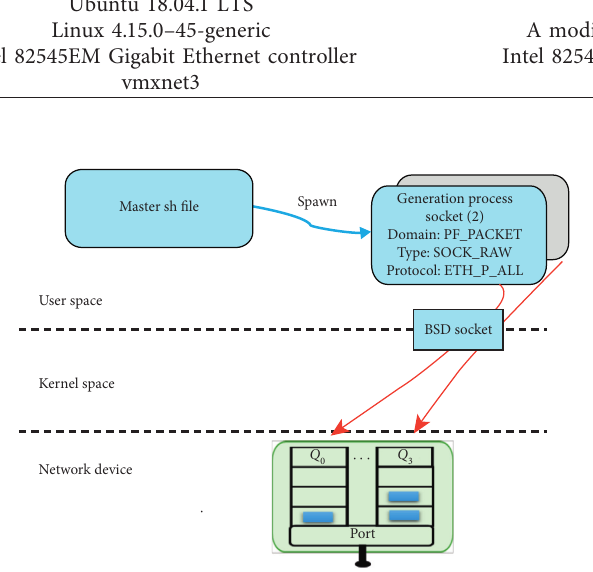
Figure 2: Traffic generator architecture.